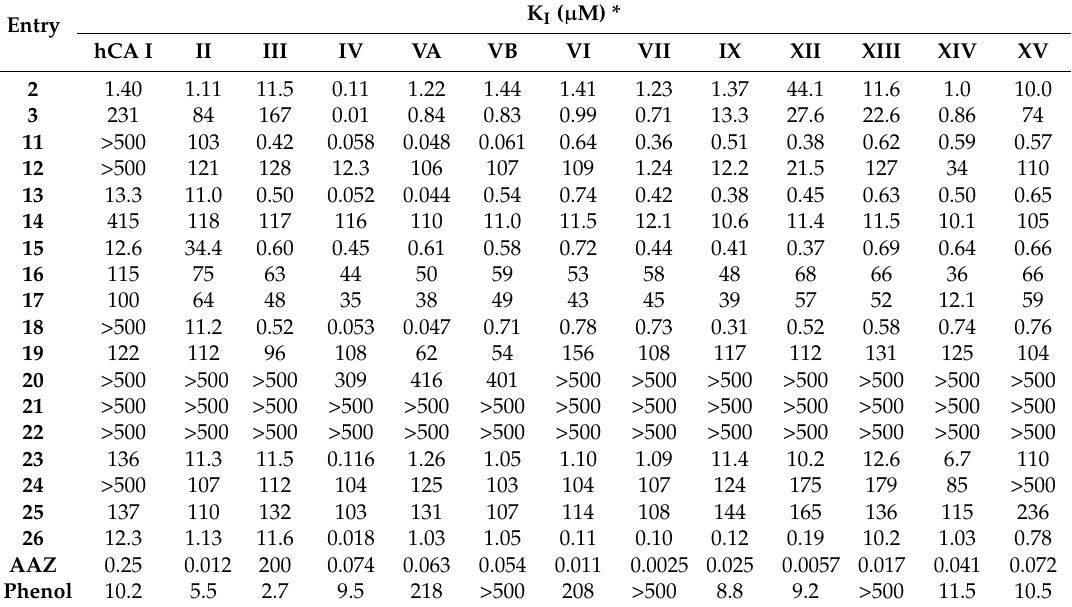
Table 1. Human (h)CA I–XII, XIV and murine (m)CA XIII and XV inhibition data with polyamines 2 , 3 and 11 – 26 . Data relative to ethylenediamine 10 are not shown